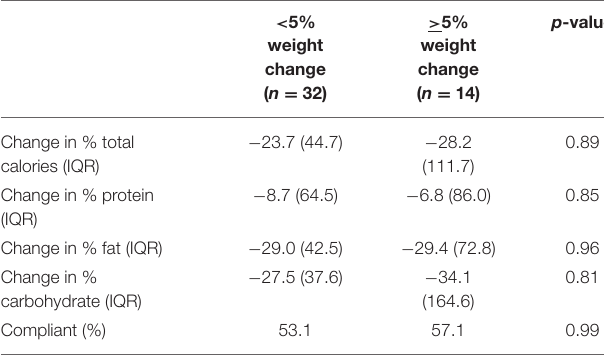
TABLE 4 | Change in macronutrient intake by study participants who lost at least 5% of their body weight as compared to those that did not. <